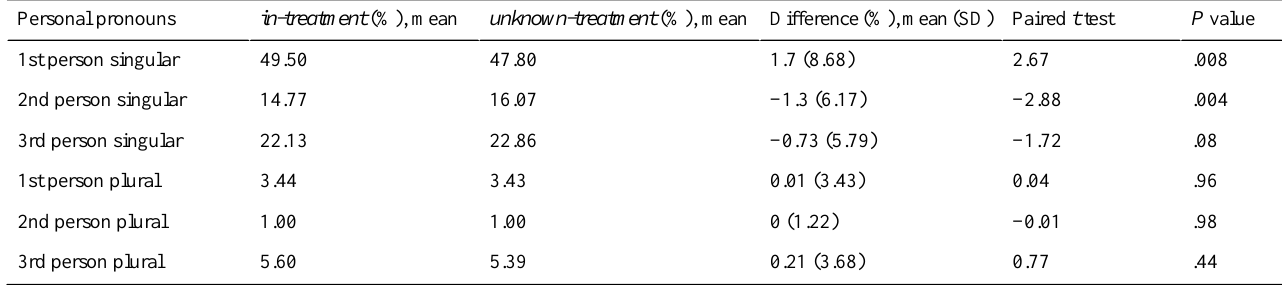
Table 5. Mean percentages of personal pronouns compared between in-treatment and unknown-treatment datasets.